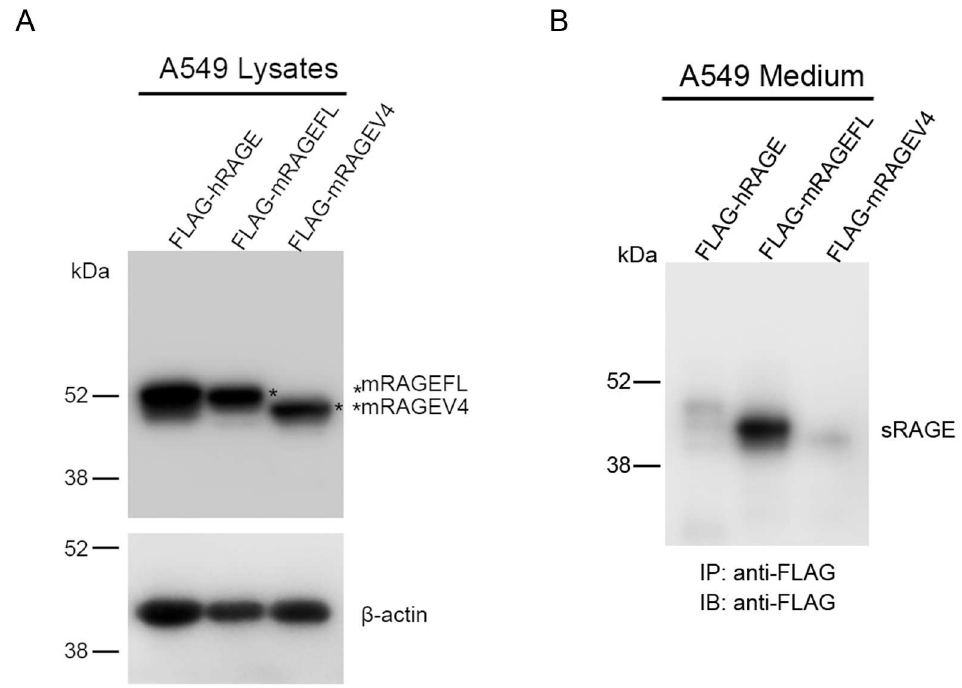
Fig 3. Examinationof RAGE shedding usingimmunoprecipitation. A549 cells were transfected with FLAG-tagged hRAGE, mRAGEFL, and mRAGEV4 expression vectors. Cell culturemediumwas collected16 h post-transfection and immunoprcipitatedwith anti-FLAG antibodies.The cell lysates (A) and immunoprecipitants(B) were resolved with SDS gel and westernblotted with anti-FLAGantibodies conjugated with HRP. * marksthe resolved mRAGEFL and mRAGEV4, and β -actinlevel in the cell lysates was used as the loadingcontrolfor cell lysates.